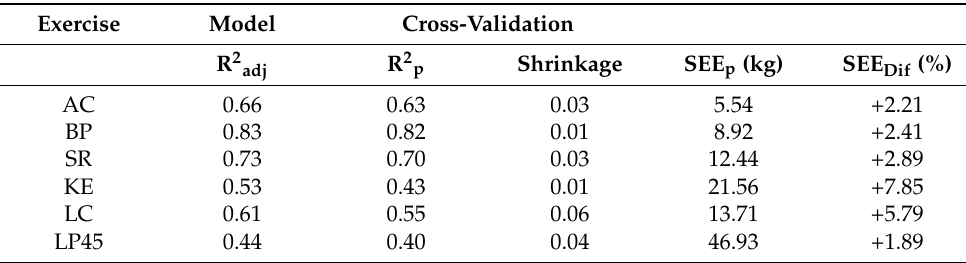
Table 3. Cross-validation values from PRESS analysis.